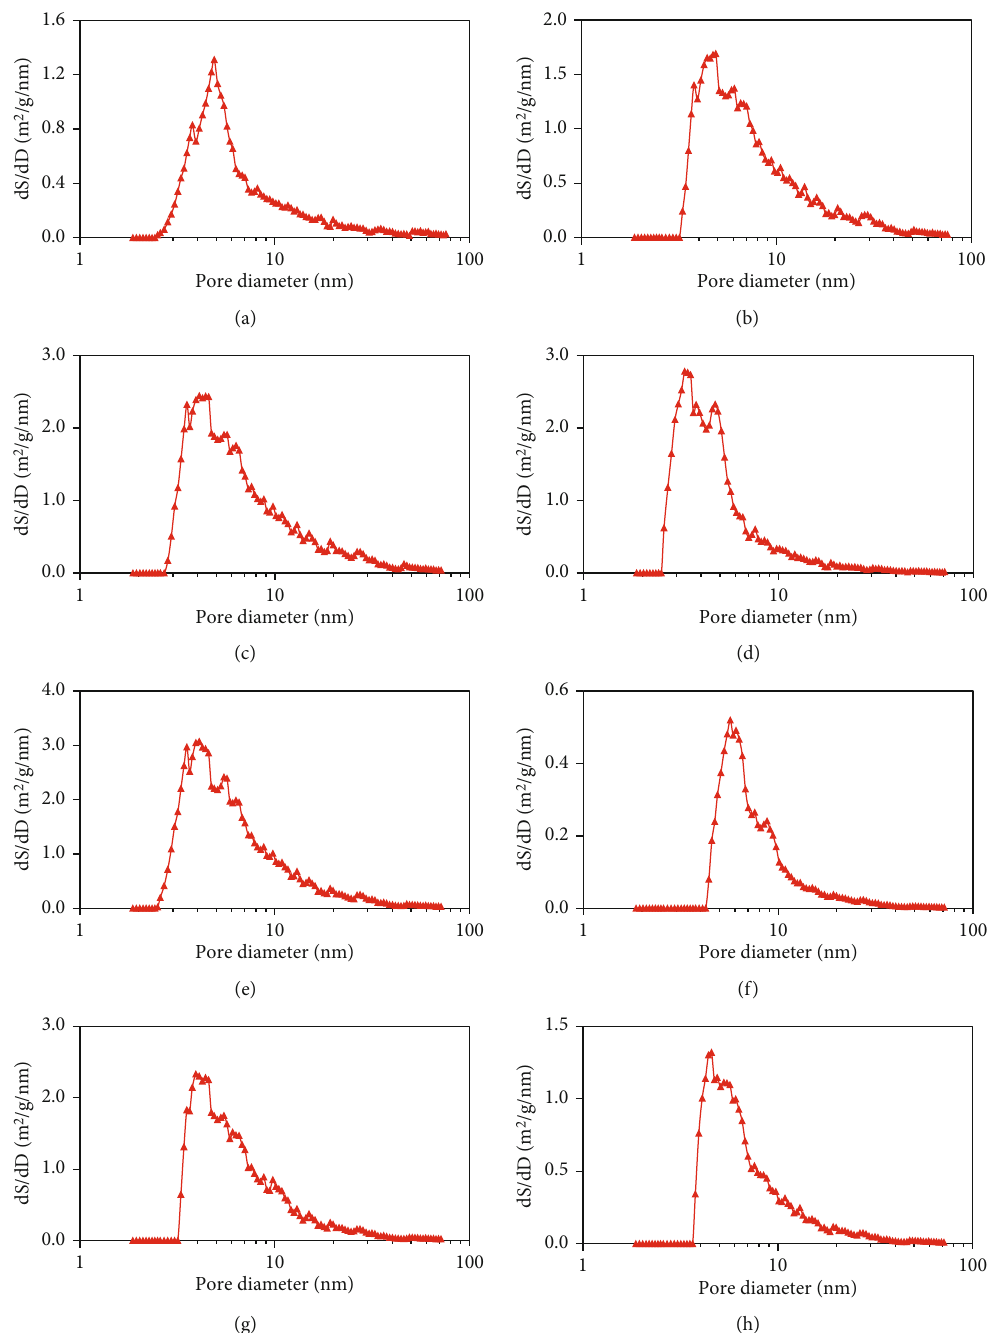
Figure 6: BET desorption model pore speci fi c surface area distribution of Qigequan Formation mudstone samples. (a) H-1: pure mudstone; (b) H-2: pure mudstone; (c) H-3: pure mudstone; (d) H-4: silty mudstone; (e) H-5: silty mudstone; (f) H-6: silty mudstone; (g) H-7: sandy mudstone; (h) H-8: sandy